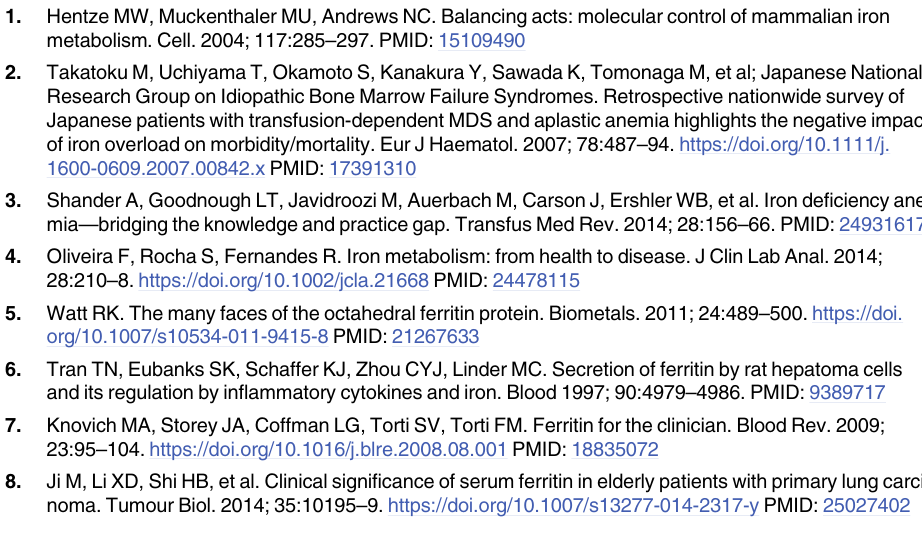
S1 Table. The associations between ferritin and mortality after excluding participants who died within the first 24 months since the baseline interview, and participants with anaemia or increased of hsCRP